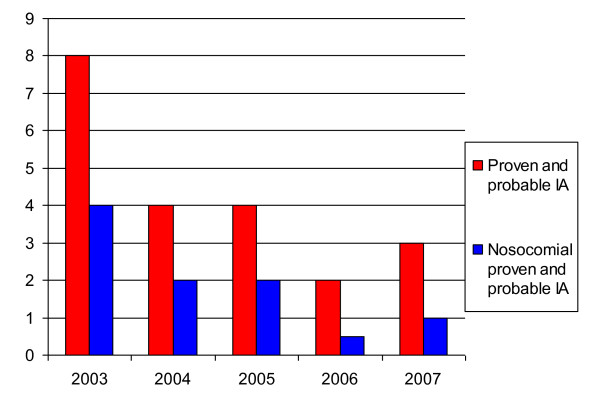
Yearly incidence densities of invasive Aspergillosis (IA).